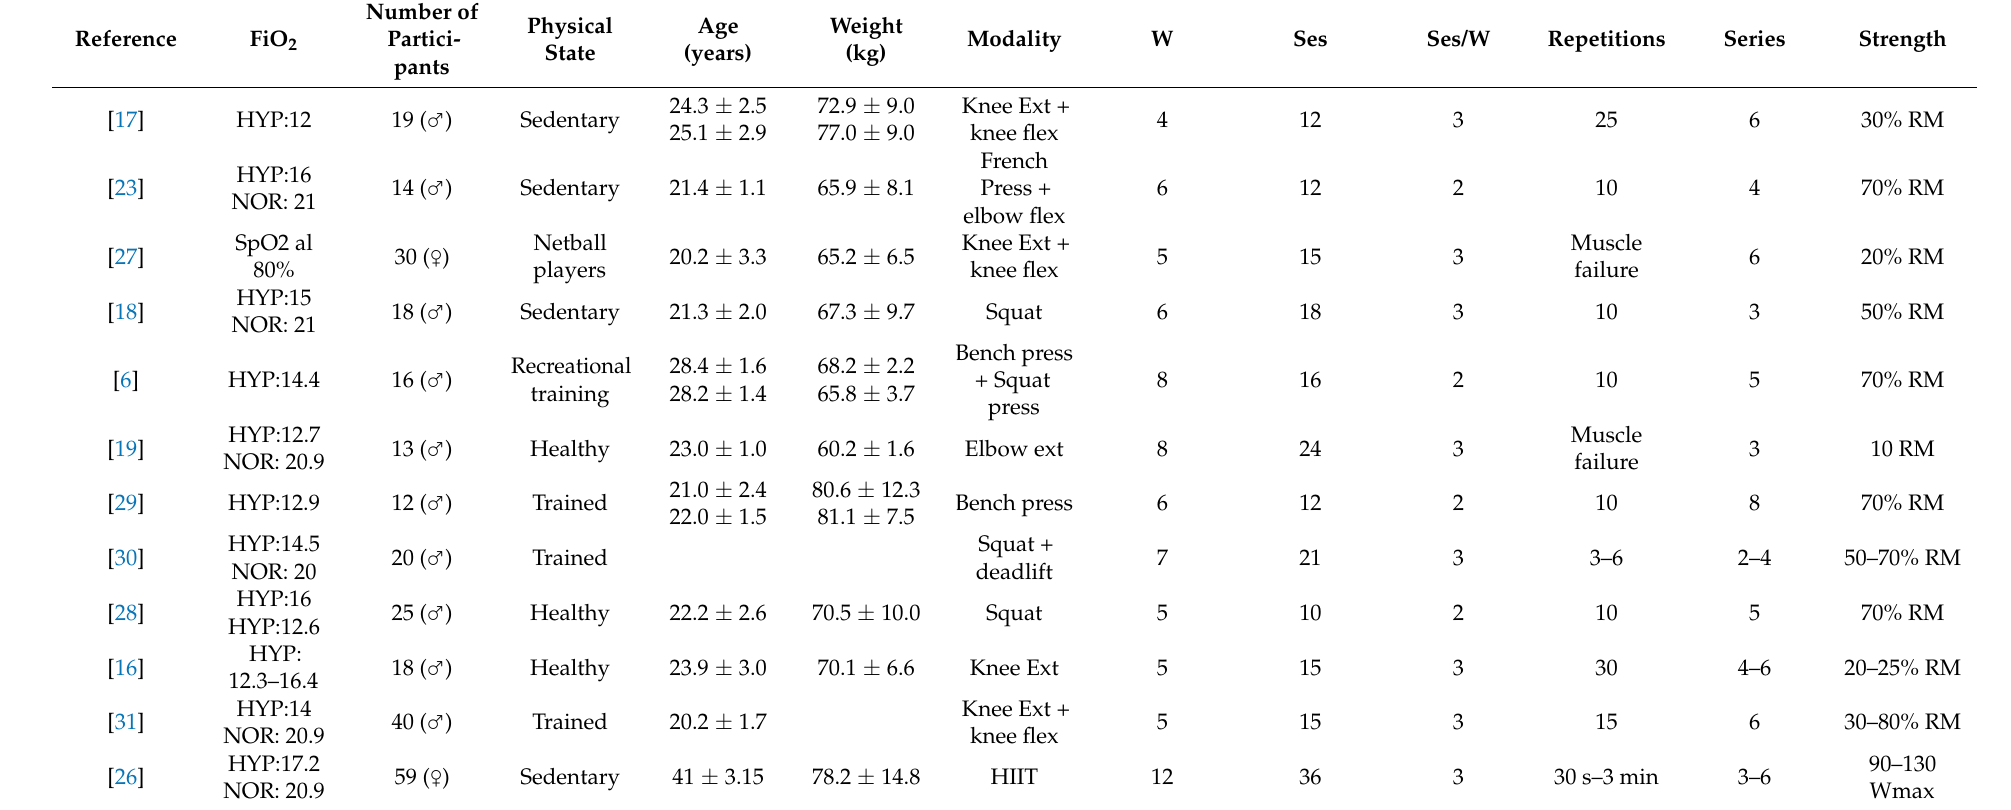
Table 1. Characteristics of the selected documents for the systematic